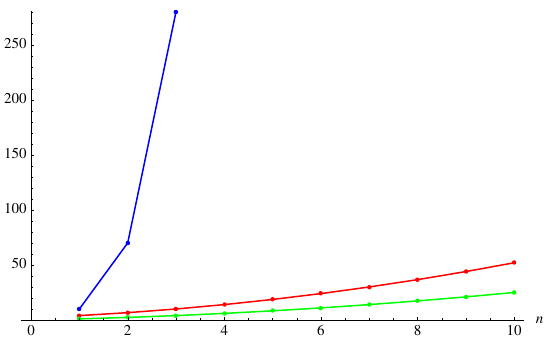
Figure 12 . We take the ratio of the four determinants in the second and third line in eq. (8.8), denoted as m ( ‘ ) , for i = 1 , · · · , 4 . We plot m 1 (1+ n, 2+ n, 3+ n ) i 1 , ‘ 2 , ‘ 3 and m 1 (1+ n, 2+ n, 3+ n ) (green), with n = 1 , · · · . As we can see, m m 4 (1+ n, 2+ n, 3+ n ) ratio is an increasing function with